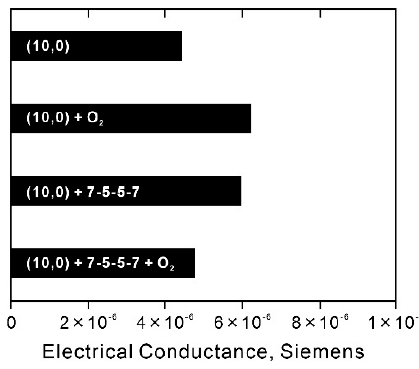
Figure 8. Effect of O 2 adsorbates and 7-5-5-7 topological defects on the electrical conductance of semiconducting zig-zag (10, 0) SWCNTs. Reprinted with permission from ref. [67]. Copyright 2023 Elsevier, Ltd.